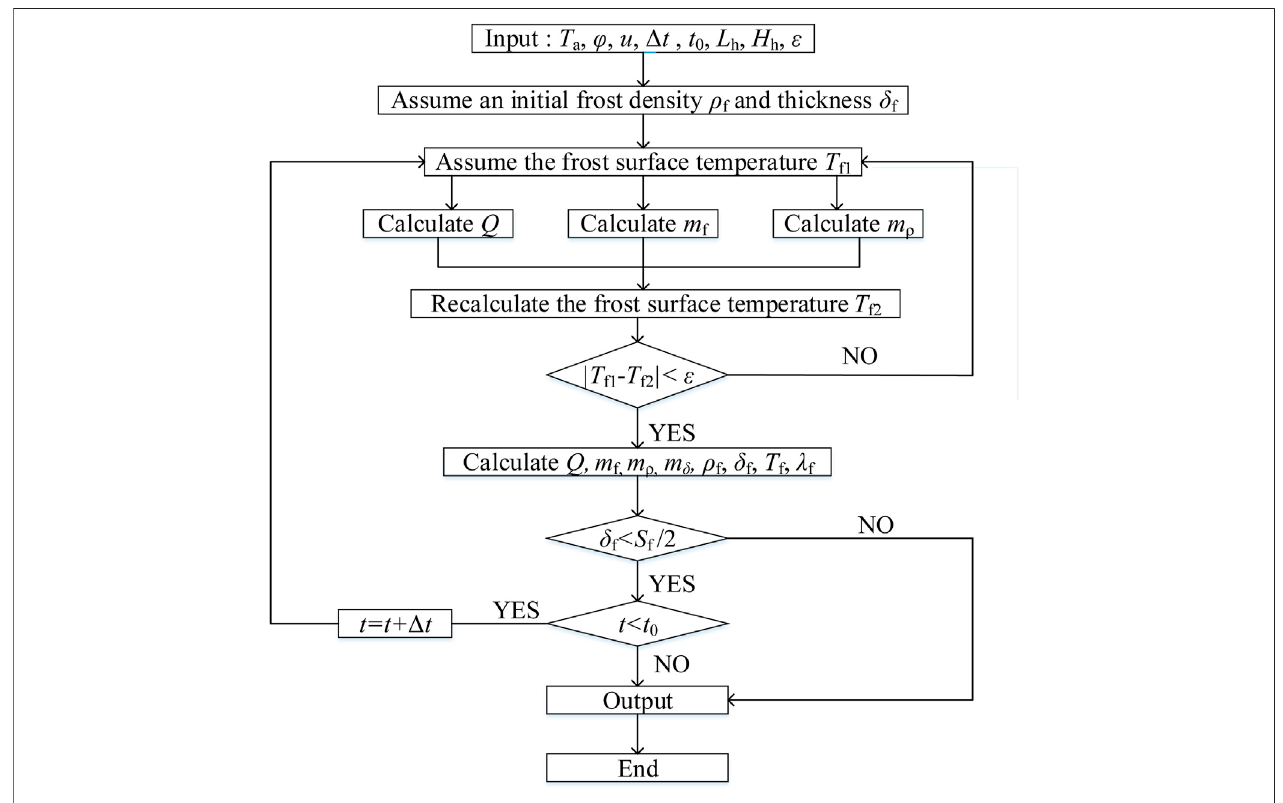
FIGURE 5 | Logic diagram of the model calculation process.